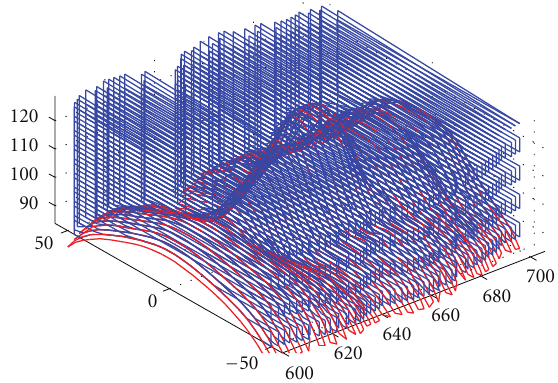
Figure 13: Entire tool path for the processing